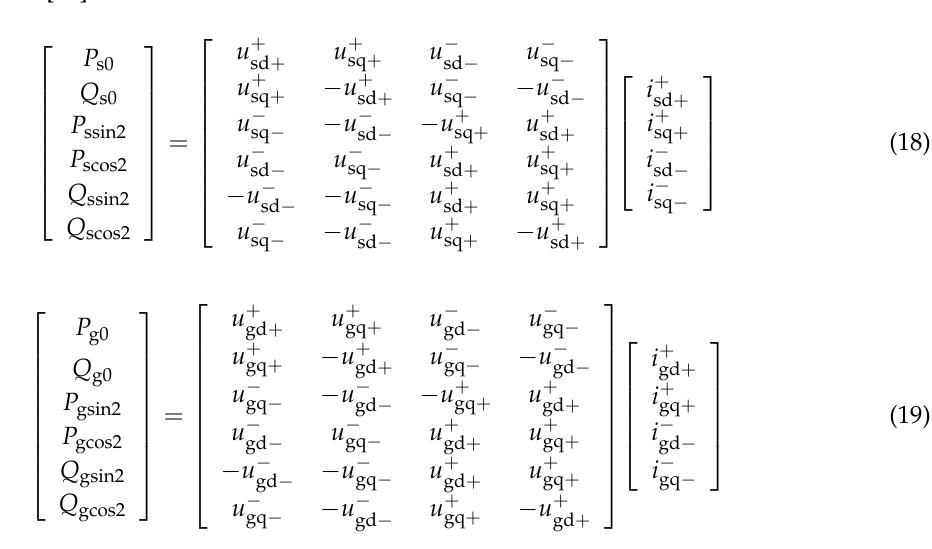
Figure 2. The grid voltage: ( a ) Voltage phase A drops from 1 p.u. to 0.8 p.u. at 2 s; ( b ) Voltage phase A rises from 0.8 p.u. to 1.2 p.u. at 2.6 s.